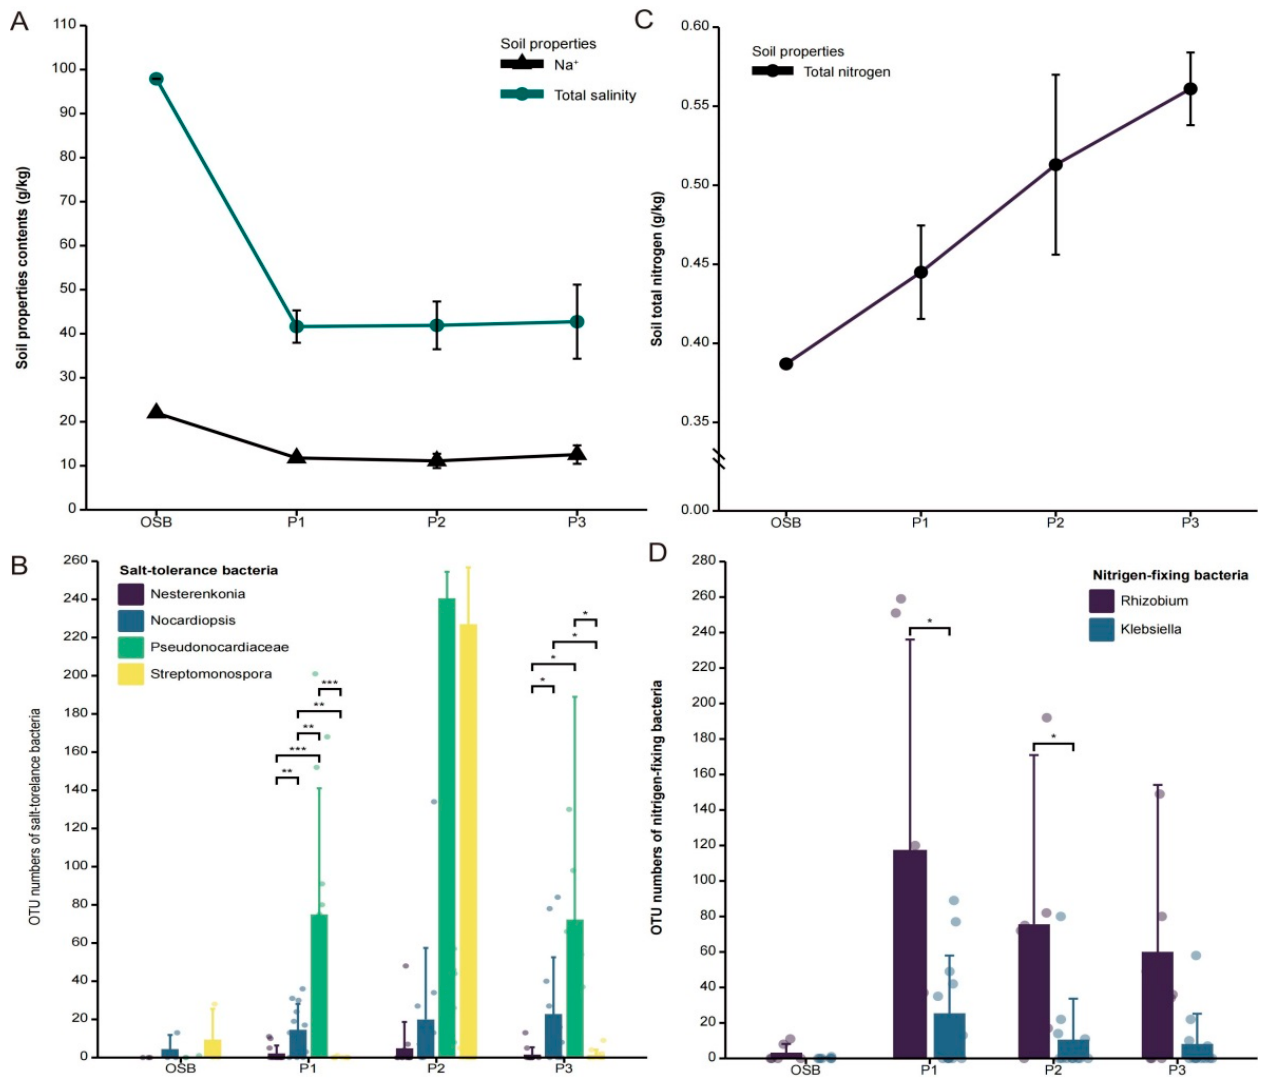
Figure 8. ( A ) Soil total salinity and Na + contents related to three different halophytes and OSB; ( B ) the OTU abundance of the several halophilic Actinomycetes associated with three different halophytes and OSB; ( C ) total soil nitrogen content related to three different halophytes and OSB; ( D ) average abundance of nitrogen-fixing bacteria associated with three different halophytes and OSB. * p < 0.05; ** p < 0.01; *** p <